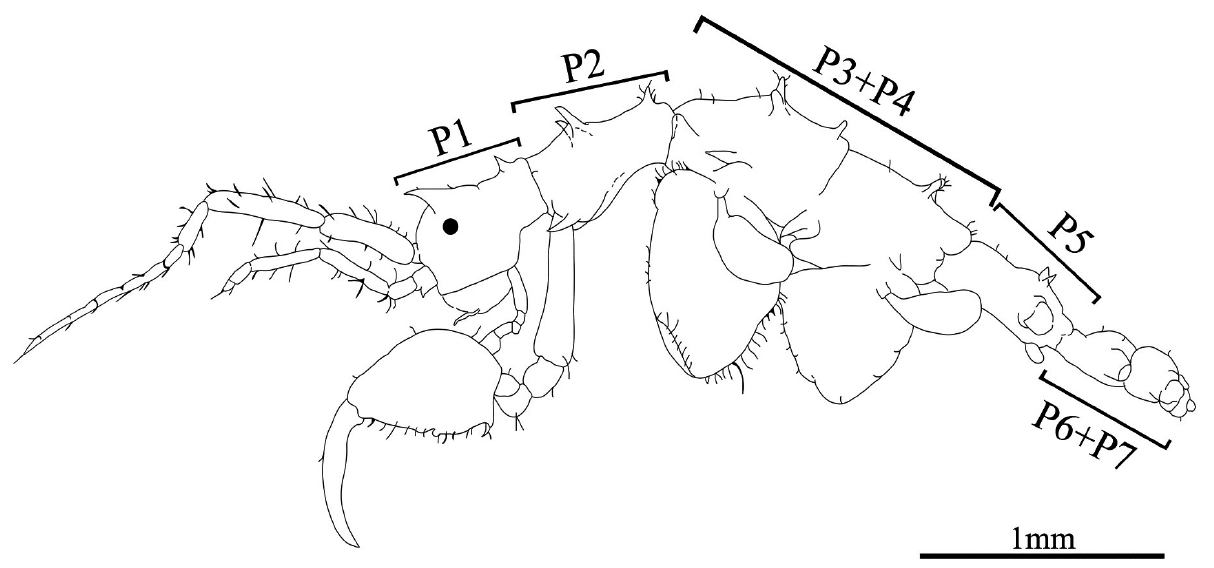
Figure 2. Indications of measurements in caprellids. Modified from Lacerda and Masunari